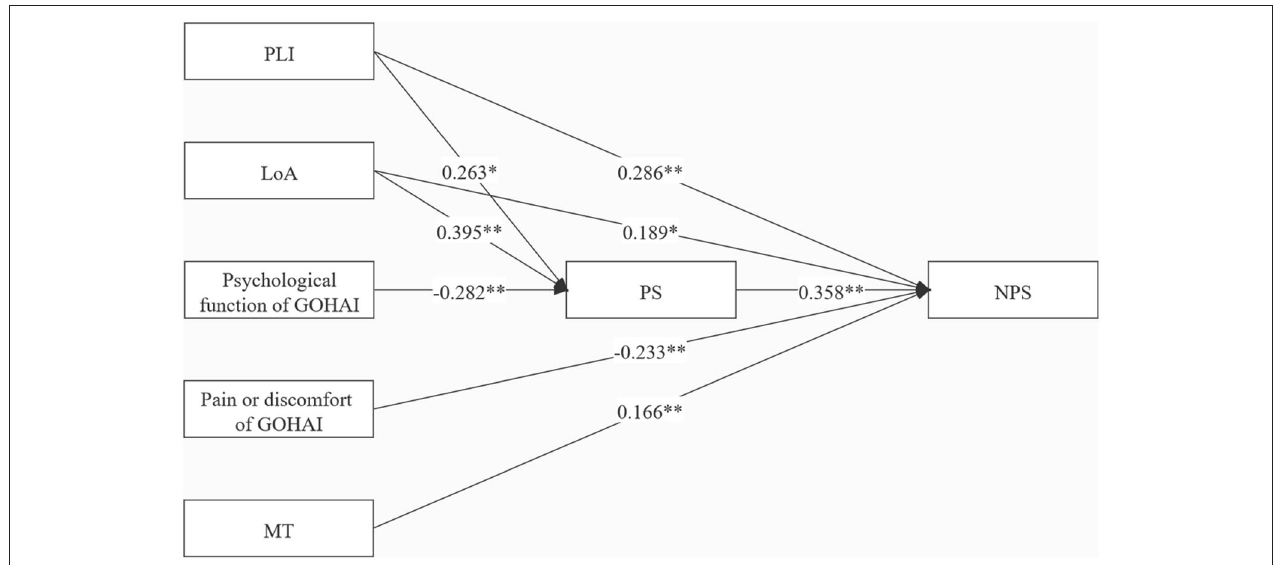
FIGURE 4 | Specific indirect effects in the mediation model. Path coefficients were standardized estimates. PLI, plaque index; LoA, loss of attachment; MT, missing teeth; GOHAI, the geriatric oral health assessment index; PS, perceived stress; NPS, neuropsychiatric symptoms; ** P < 0.001; * P < 0.05.